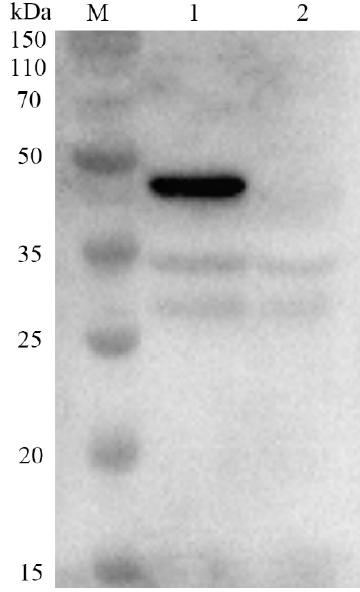
Figure 2. Western blot analysis: Specificity of VP8* protein detected by antirotavirus antiserum. M: protein marks; lane 1: crude cell extract E. coli expressing recombinant VP8* proteins; lane 2: protein expressed with the empty pET32a plasmid vector.